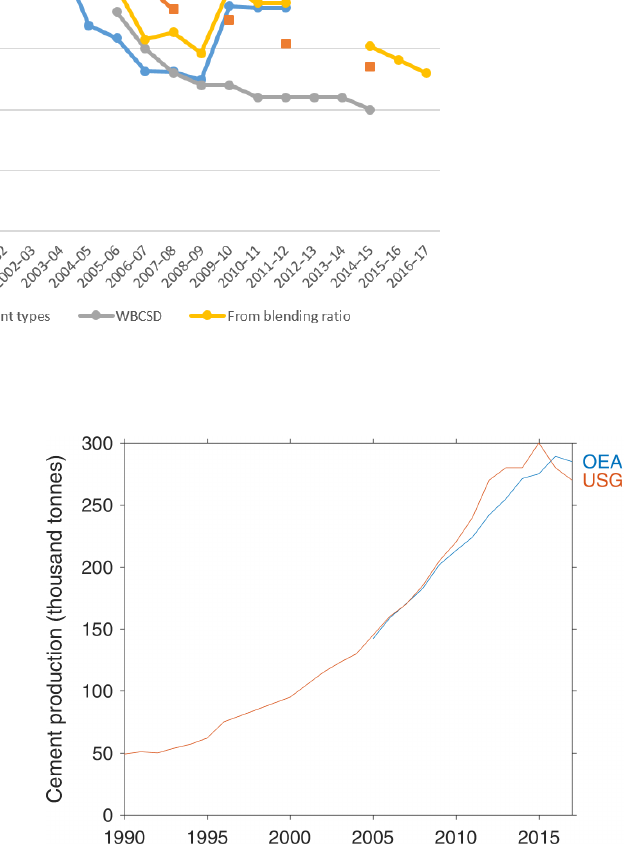
Figure C6. Comparison of Indian cement production data from USGS and OEA, the latter beginning in